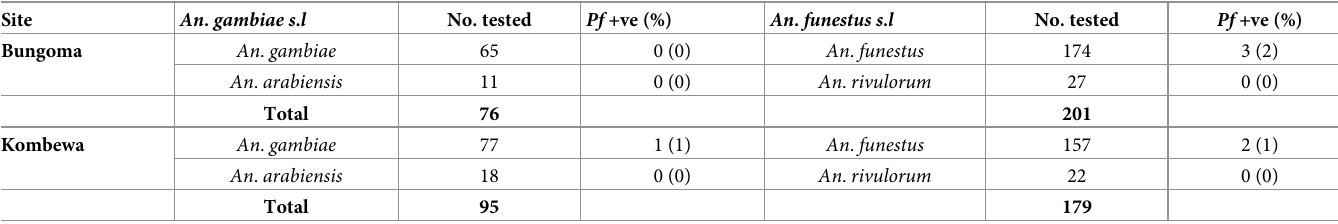
Table 4. Sporozoite rate of Anopheles mosquitoes sampled from indoors in Bungoma and Kombewa, November 2019 to November 2020. Site An . gambiae s . l